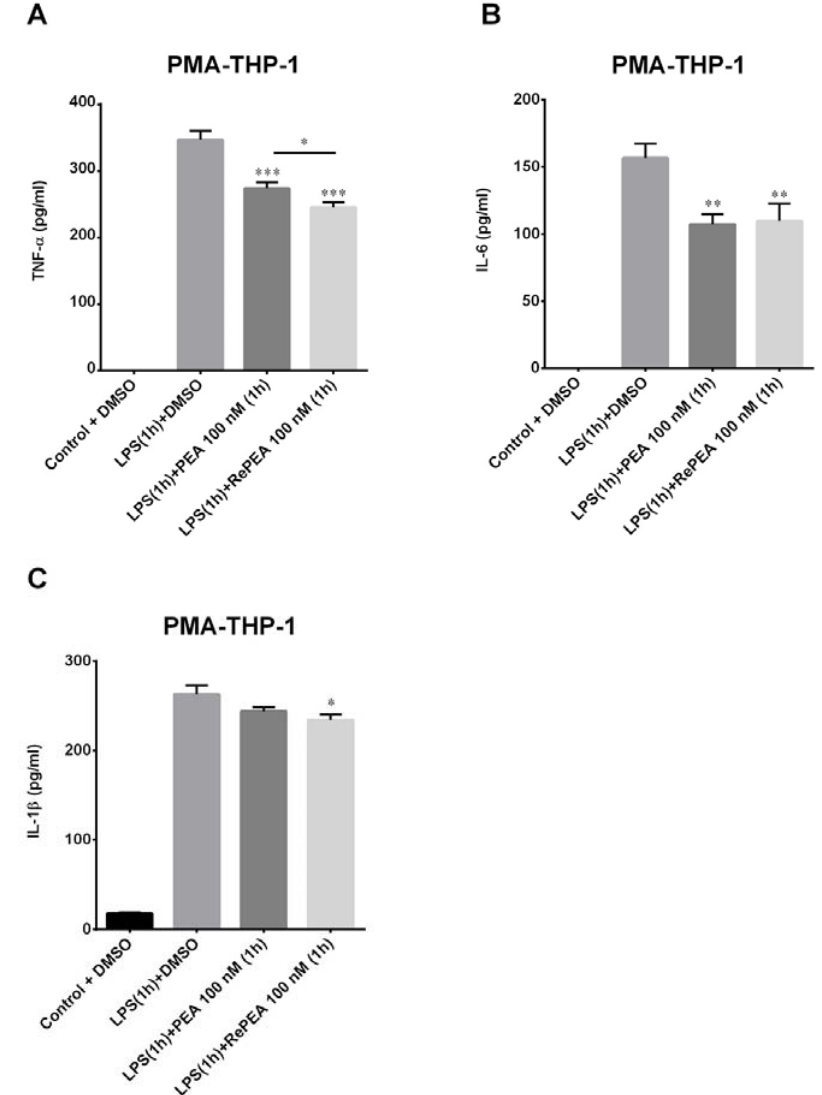
Figure 12. Release of TNF ‐α IL ‐ 6, and IL ‐ 1 β at 24 h after LPS application. The human macrophages (PMA ‐ THP ‐ 1) were stimulated with LPS at 10 ng/mL for 1 h; then, LPS ‐ containing medium was removed and cells were incubated for 1 h with 100 nM PEA and its analogue, RePEA. Then, medium was replaced with fresh RPMI. The amount of TNF ‐α ( A ), IL ‐ 6 ( B ), and IL ‐ 1 β ( C ) released into the culture medium was quantified after 24 h from LPS administration. Data are presented as mean ± S.E.M. ( n = 3 independent experiments). Significant differences from LPS were determined using nonparametric one ‐ way analysis of variance (ANOVA) with post hoc Dunnett’s multiple comparison tests at * p < 0.05; ** p < 0.01; *** p < 0.001. Difference between treatment with PEA and RePEA was determined using unpaired t ‐ test * p < 0.05.